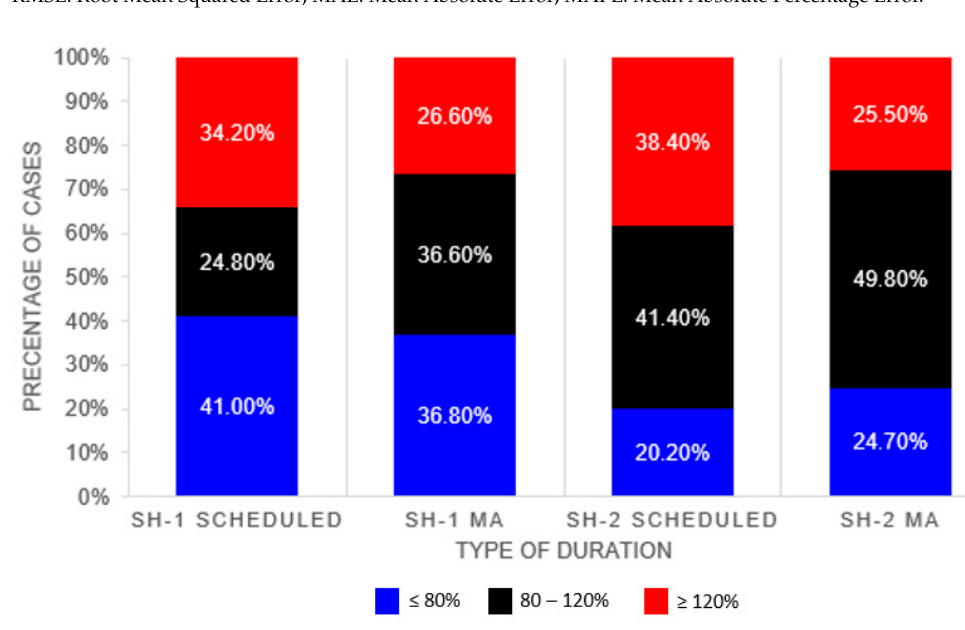
Table 3. Performance of scheduled vs. MA duration.